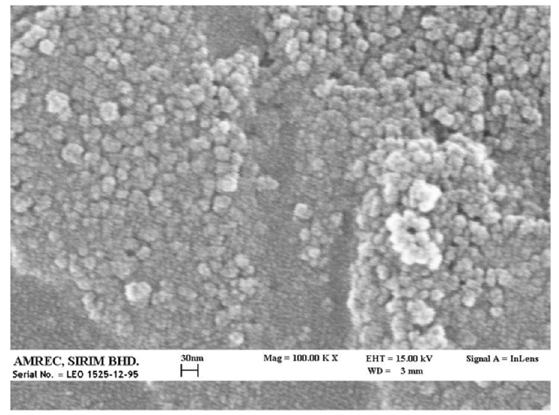
Figure 2. SEM image of DCX-loaded P(3HB- co -4HB) nanoparticles (DCX-PHB70).